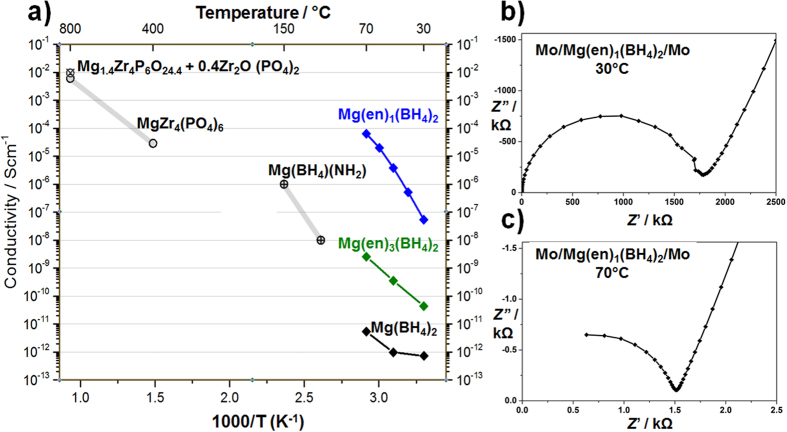
(a) Temperature dependence of ionic conductivity of Mg(BH4)2, Mg(en)3(BH4)2 and Mg(en)1(BH4)2, together with literature data for MgZr4(PO4)613, Mg1.4Zr4P6O24.4 + 0.4Zr2O(PO4)21415 and Mg(BH4)(NH2)17. (b,c) Nyquist plots of Mo/Mg(en)1(BH4)2/Mo at 30 and 70 °C, respectively.